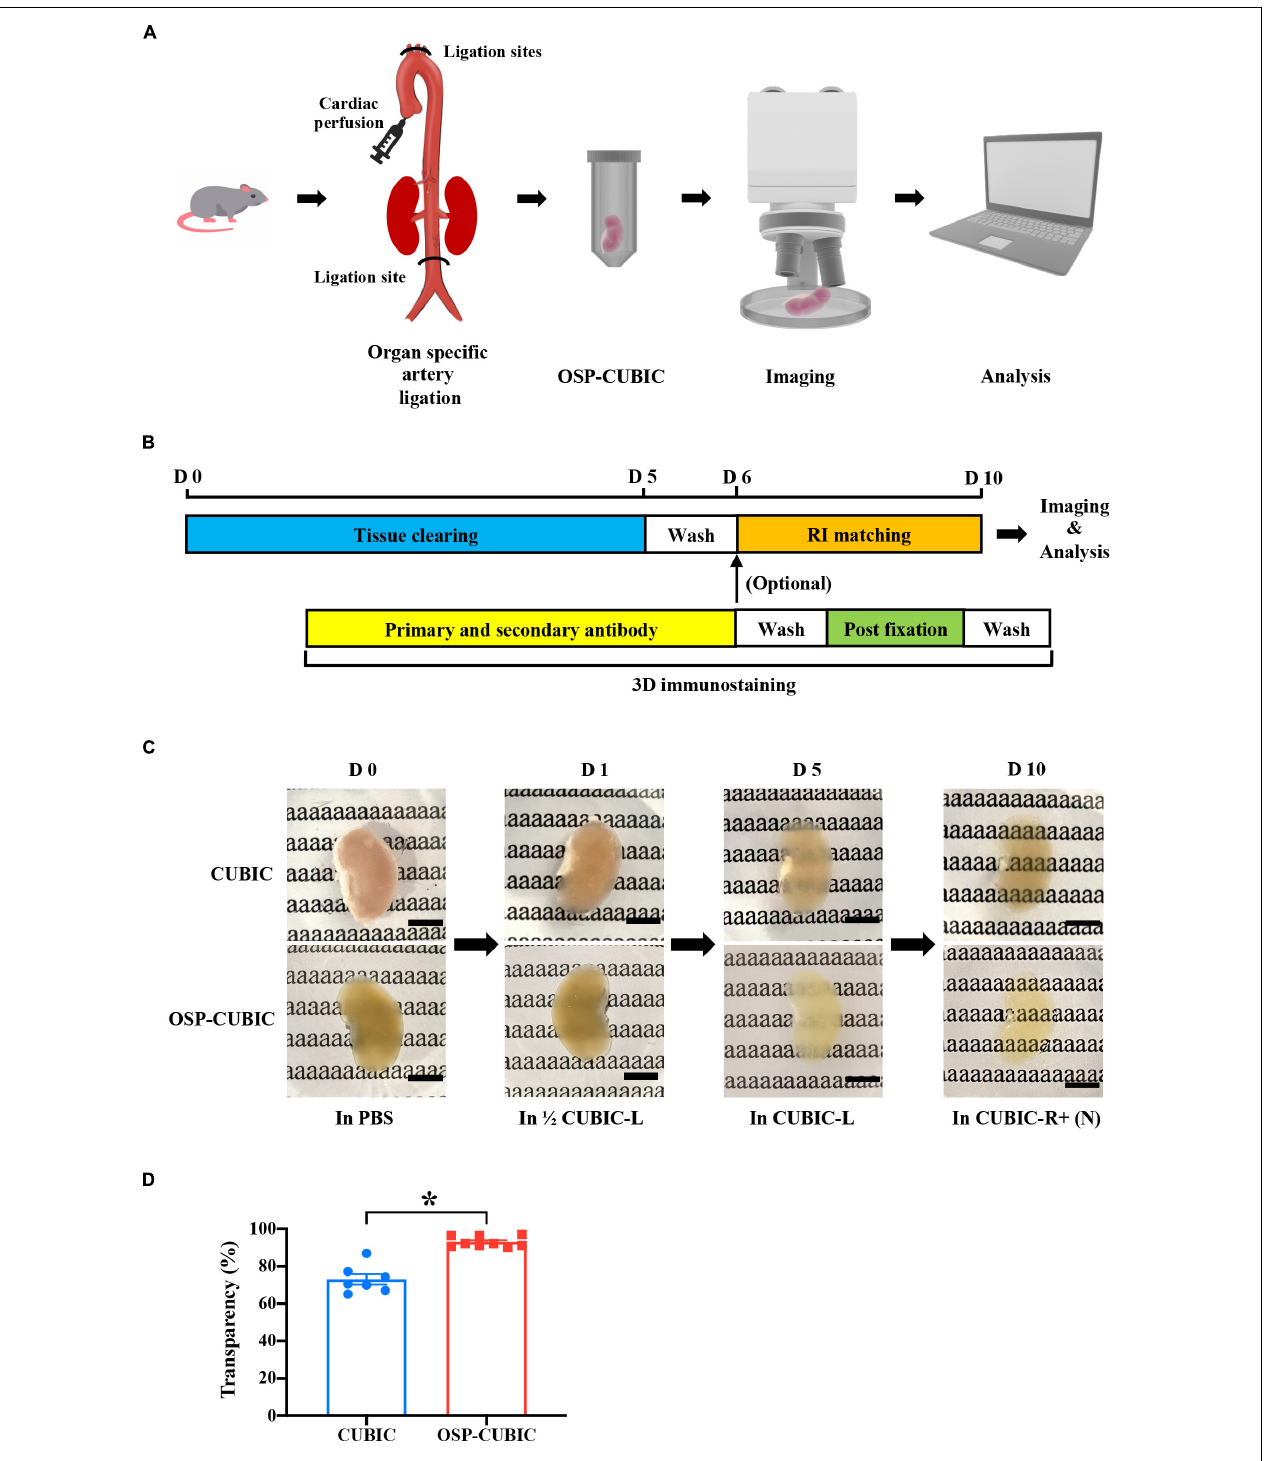
FIGURE 1 | Optimized OSP-CUBIC clearing achieves high transparency of whole-mount kidney. (A) Overview of organ-specific perfusion-CUBIC clearing, 3D immunostaining, imaging, and image analysis system. (B) Protocol of three major components of OSP-CUBIC: tissue clearing, 3D immunostaining, and RI matching. (C) Photos of cleared whole kidney by conventional CUBIC and OSP-CUBIC at different time points. For details of CUBIC-L and CUBIC-R + (N), see Section “Materials and Methods”. Scale bar = 5 mm. (D) Quantification of transparency of the kidneys by conventional CUBIC and OSP-CUBIC on day 10 (CUBIC, n = 7; OSP-CUBIC, n = 9). OSP-CUBIC, organ specific perfusion CUBIC; RI, refractive index; 3D, three-dimensional; PBS, phosphate-buffered saline; D, day. * P < 0.05.